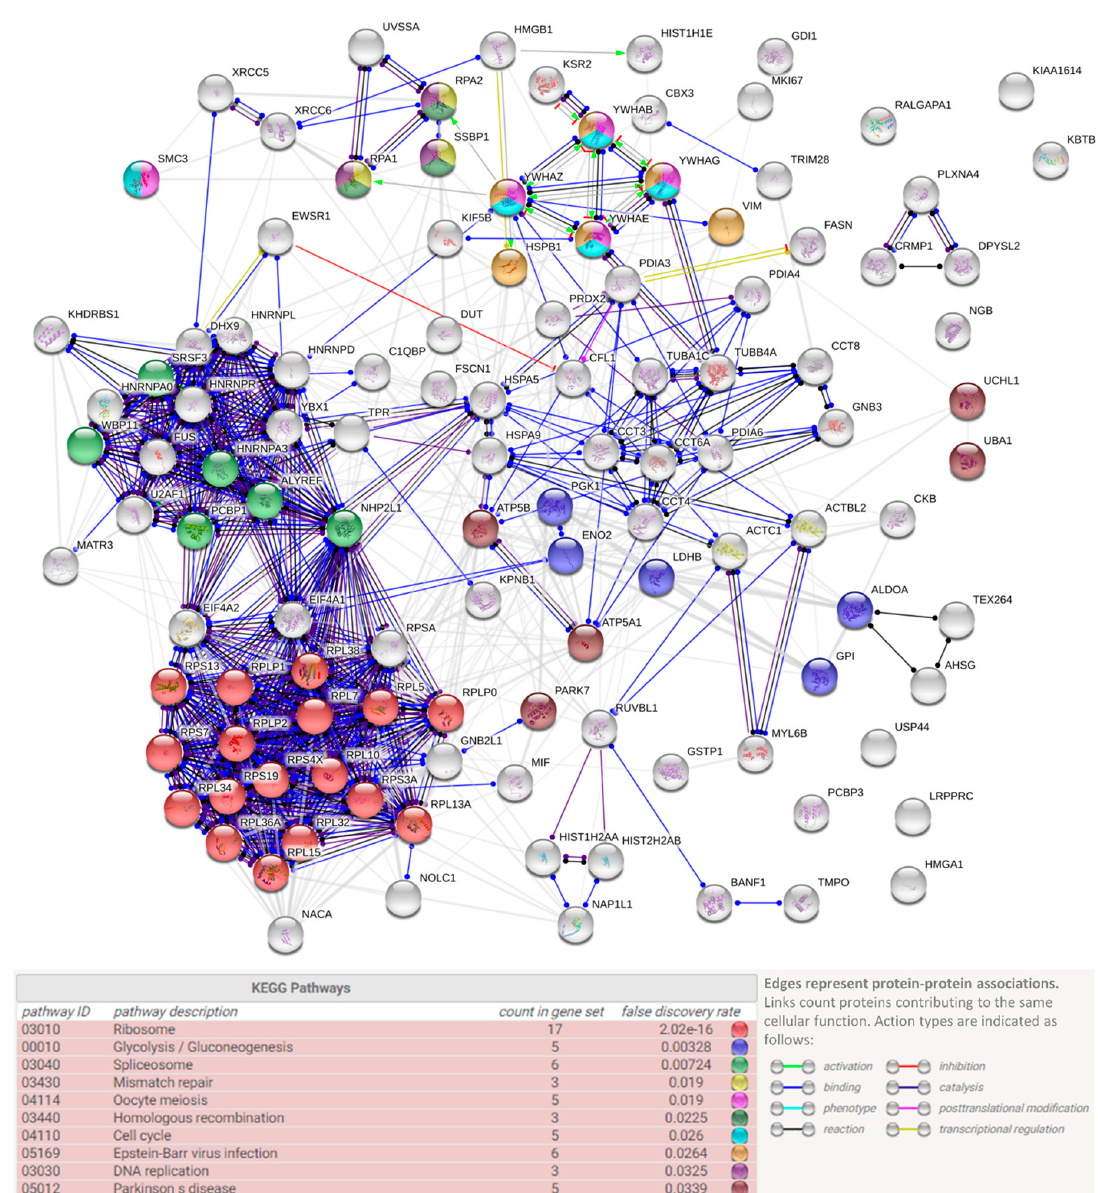
Figure 7. hNgb protein interaction network. Representation of protein ‐ protein associations of the hNgb ‐ specific binders identified in either hNgb ‐ EGFP S1 or S2. The interaction network was